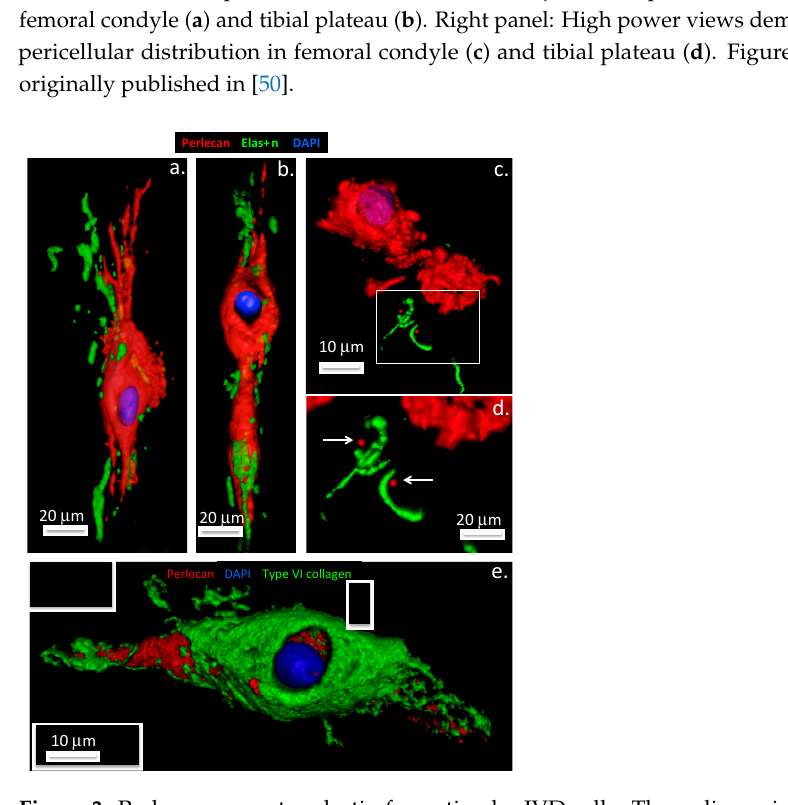
Figure 3. Perlecan promotes elastin formation by IVD cells. Three-dimensional surface rendered models of perlecan, elastin and type VI collagen immunolocalization in intervertebral disc tissues, based on confocal data originally published in [38,54]. Upper panel: Annulus fibrosus cells shown in ( a , b ), nucleus pulposus cells in ( c , d ). Secretion of co-acervated tropoelastin (green) is visible at the poles of the elongate, spindle shaped annulus fibrosus cells, perlecan label (red) extends outwards from the pericellular matrix compartment at the cell poles ( a , b ). In contrast, elastin is only sparsely distributed around NP cell clusters ( c , d ). Detail of the elastin labeling (boxed area in ( c ) is shown in ( d ) Arrows denote perlecan foci associated with elastin label in ( d ). Lower panel: The lower image ( e ) shows the overlapping distributions of collagen type VI (green) and pericellular perlecan label (red) within an annulus fibrosus chondron. Cell nuclei depicted in